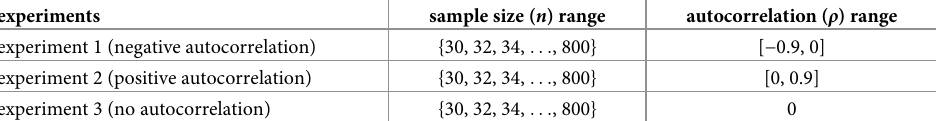
Table 2. Simulation parameter ranges for the simulation experiments reported in Fig 6. For each simulated data- set in each of the three experiments, we generated labels for both the paired and random cases, using a regular sequence of “before” and “after” labels in the paired case, and a random sequence in the random case (where, for each one of the n positions in the sequence, we randomly sampled a “before” or “after” label). Each data-set was generated with a dis- tinct autocorrelation coefficient ( ρ ) value randomly sampled from the ranges described in the third column (autocorre- lation) of the table, and with a distinct sample size ( n ) value randomly sampled within the range {30, 32, 34, ... , 800}. (Note we always sampled even values of n to make sure we have complete “before” and “after” pairs in the paired case).